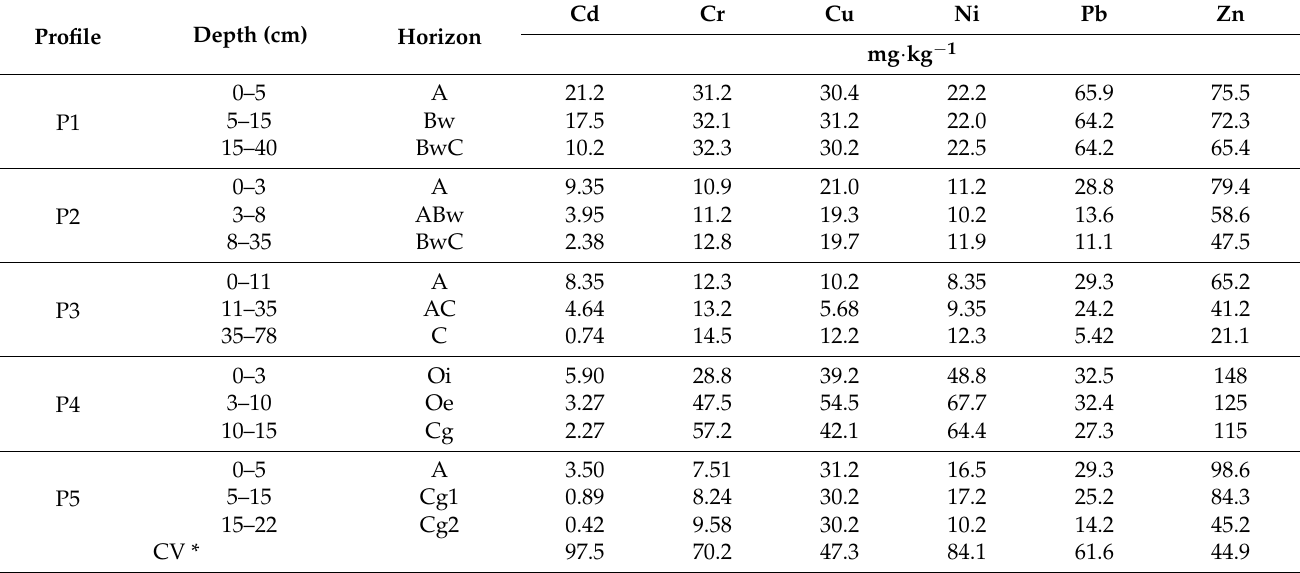
Table 4. Total content of